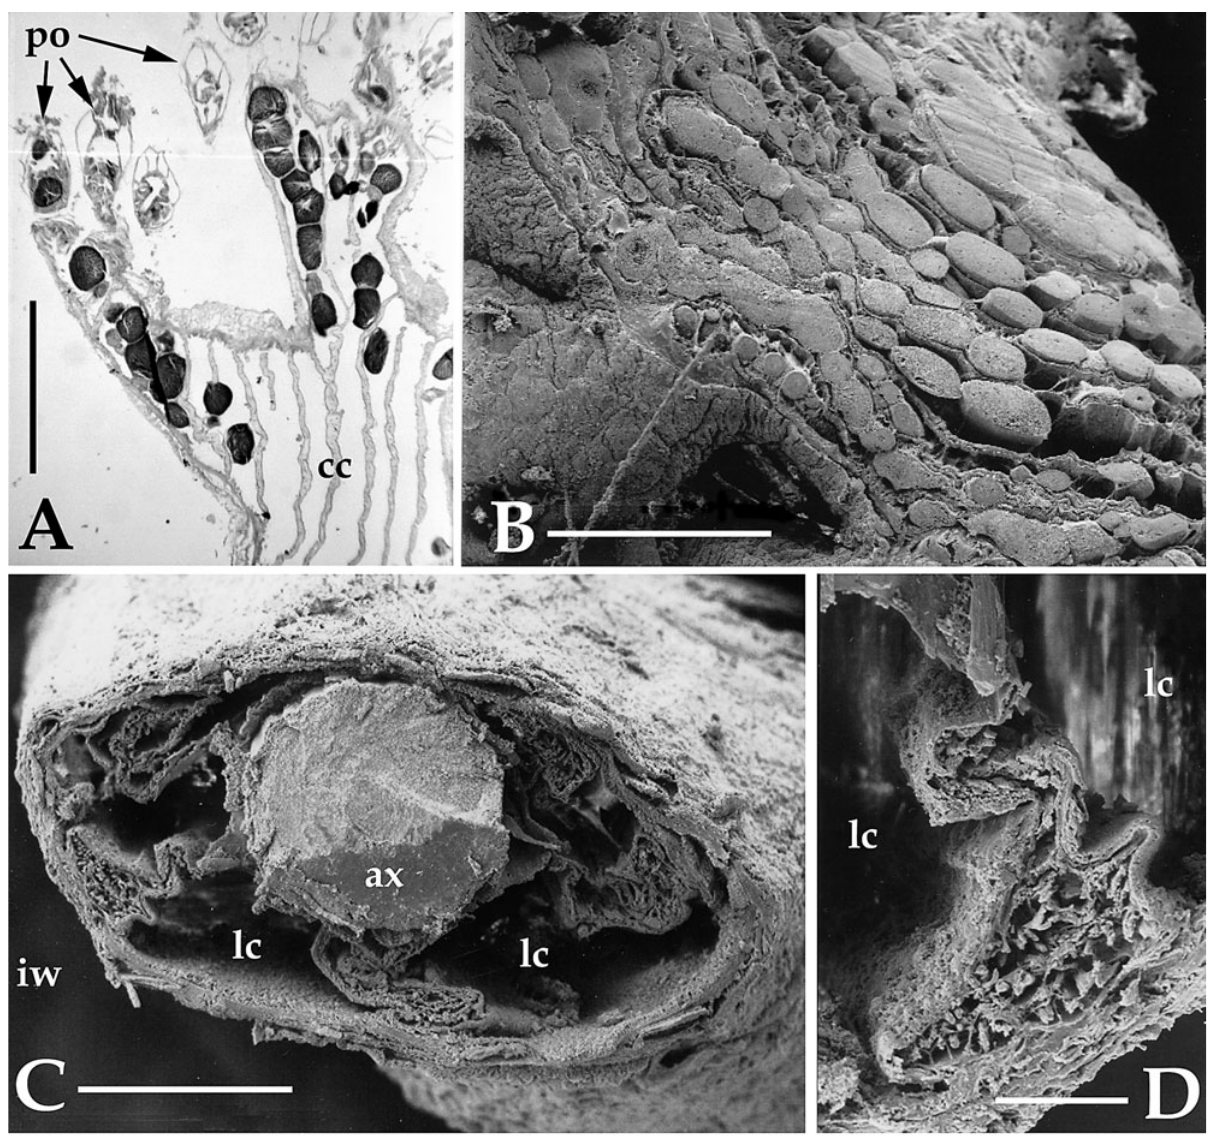
F IG . 9. – Ainigmaptilon antarcticum (Molander) from EASIZ-II cruise. A , longitudinal section of a polyp-leaf, showing the distal part of the polyps (po) and the coelenteric cavities (cc) inside the common polyp-leaf structure, note also the presence of spermatic cysts along the coe- lenteric cavities of some polyps; B , longitudinal section of a polyp-leaf showing internally the coelenteric cavities of the polyps with numer- ous spermatic cysts; C , cross section of the stem showing the axis (ax), and the ring of large longitudinal canals (lc) separated by triangular intercanal walls (iw); D , detail from C, showing a triangular intercanal wall delimiting two longitudinal canals (lc). Scale bars: A and B, 1 mm; C, 0.5 mm; D, 0.1